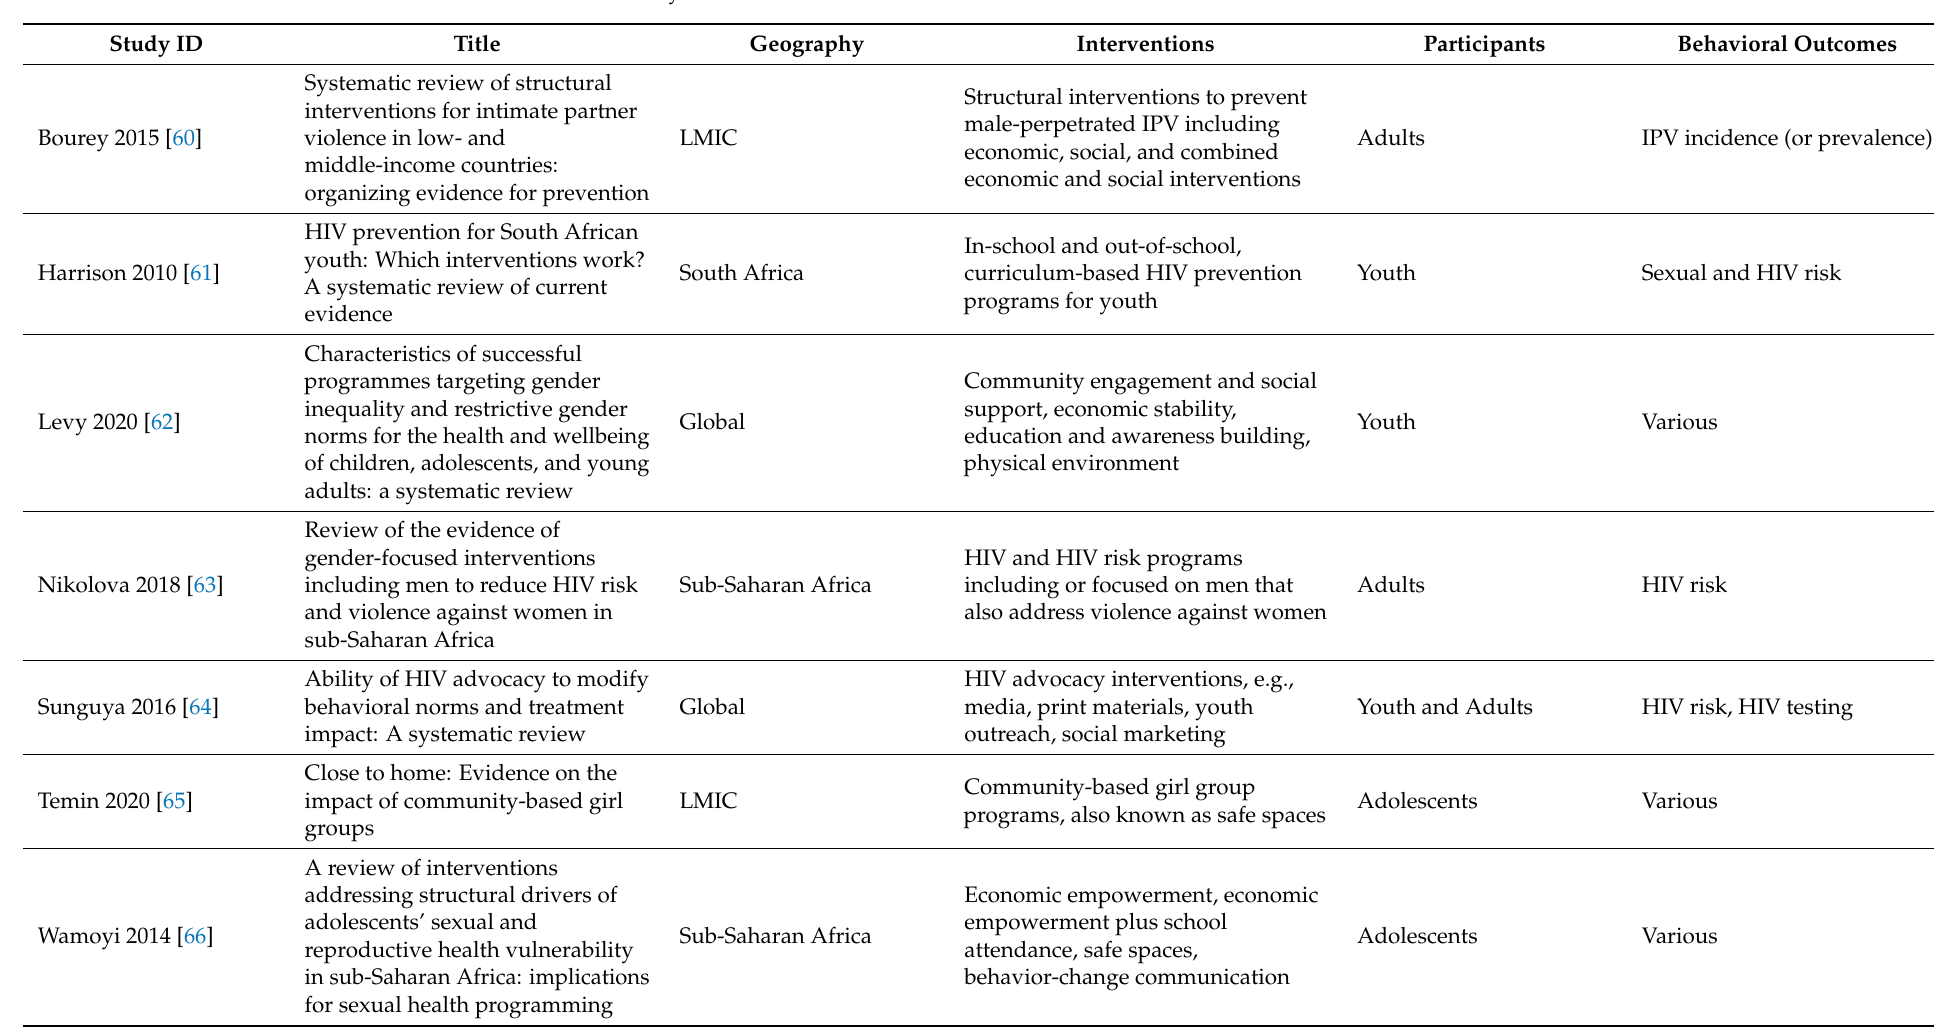
Table A1. Features of included systematic